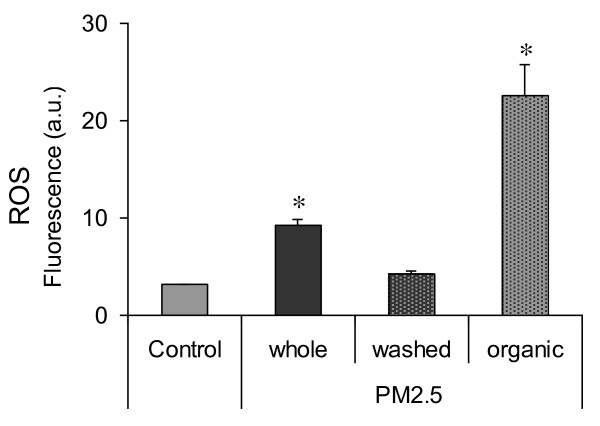
ROS formation in BEAS-2B cells. Cells were exposed for 2 h to 7.5 μg/cm2 of winter PM2.5 and to the equivalent amount of organic fraction and of washed particles. The results are reported as fluorescence arbitrary units (mean ± SEM of 3 independent experiments). * Statistically significant difference from untreated cells (control), P < 0.05.